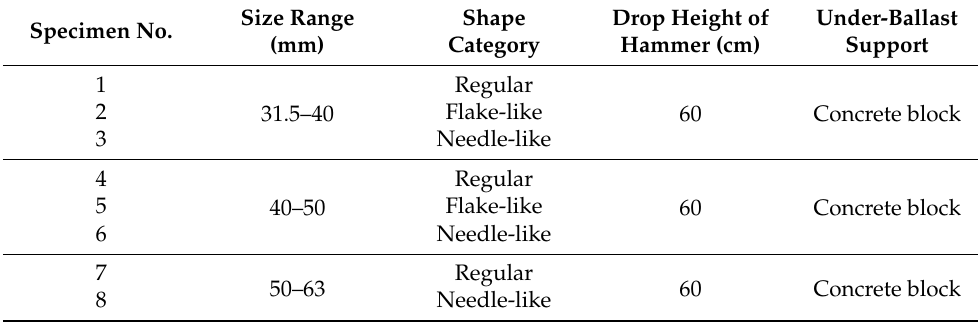
Table 1. The impact-load-test matrix for single-size ballast particles. Specimen